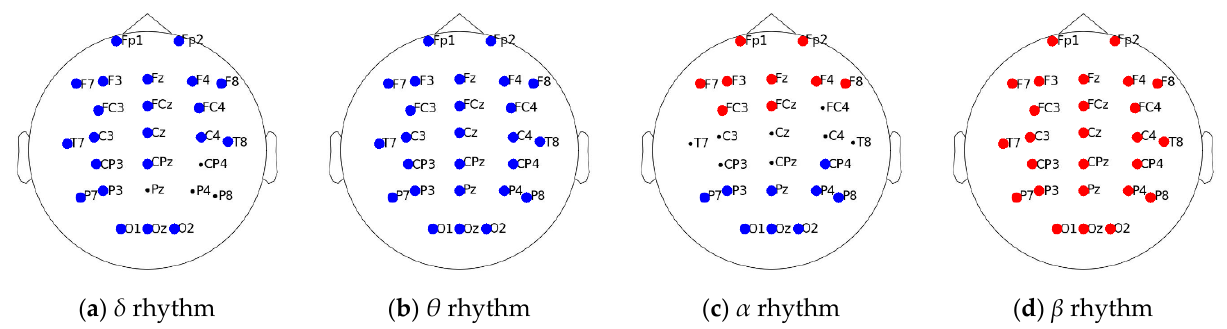
Figure 7. PSCs and NSCs for four rhythms of Sub 1.